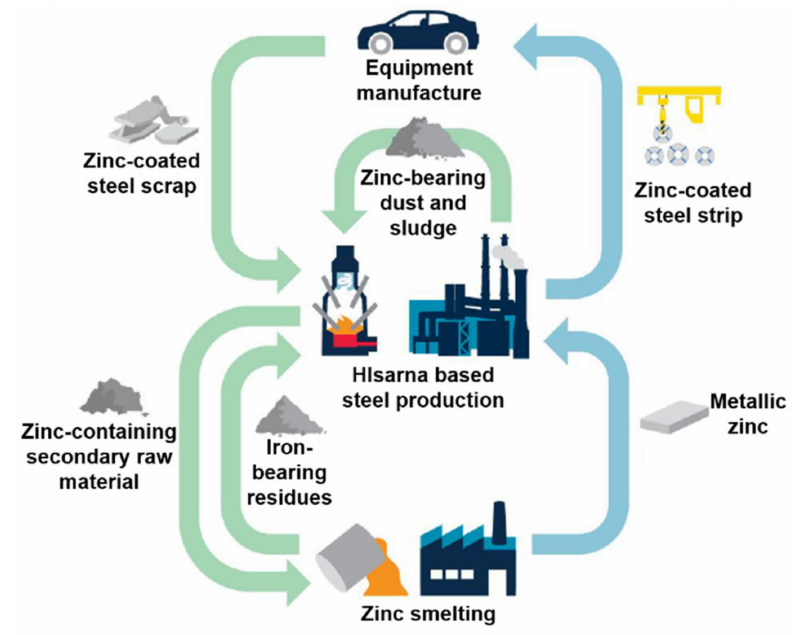
Figure 4. Concept of the Reclamet project